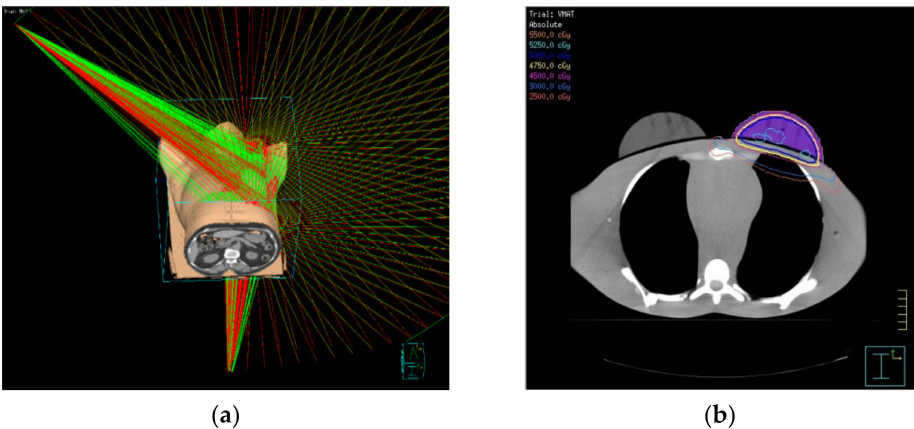
Figure 3. Treatment planning using volumetric-modulated arc therapy (VMAT) ( a ) Whole breast irradiation scheme. (Multi fields). ( b ) Dose distribution image. Yellow planning targeting area, purple tumor